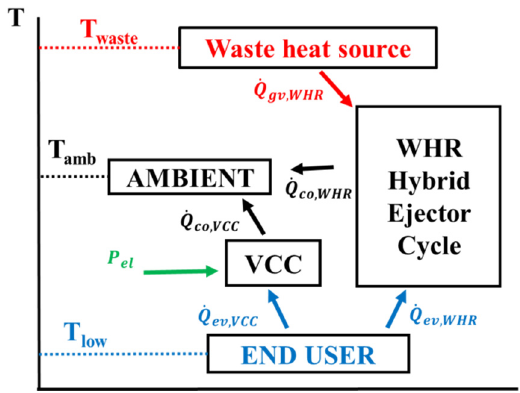
Figure 9. Schematic diagram of a combined waste heat recovery hybrid ejector cycle (WHRHEC)/VCC system to supply the end user cooling load.